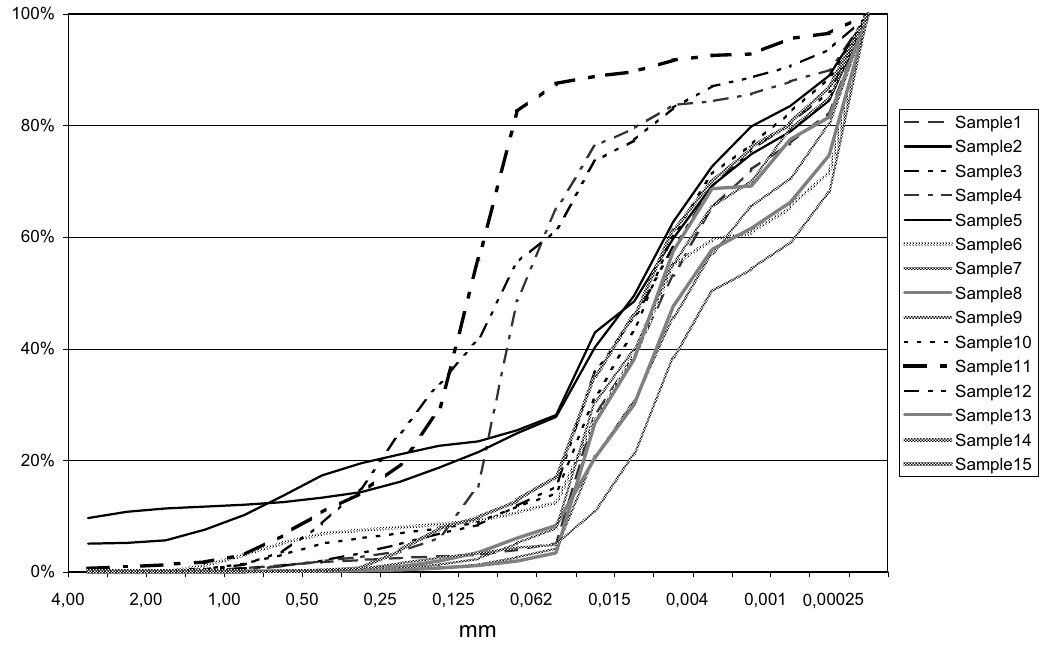
Fig. 2 – Particle size of the bottom sediments from Niterói, Guanabara Bay.